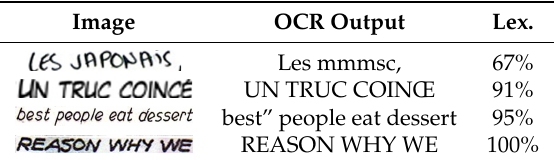
Table 1. Examples of lexicality measure. Image credits: eBDtheque dataset [88] and public domain. Image OCR Output